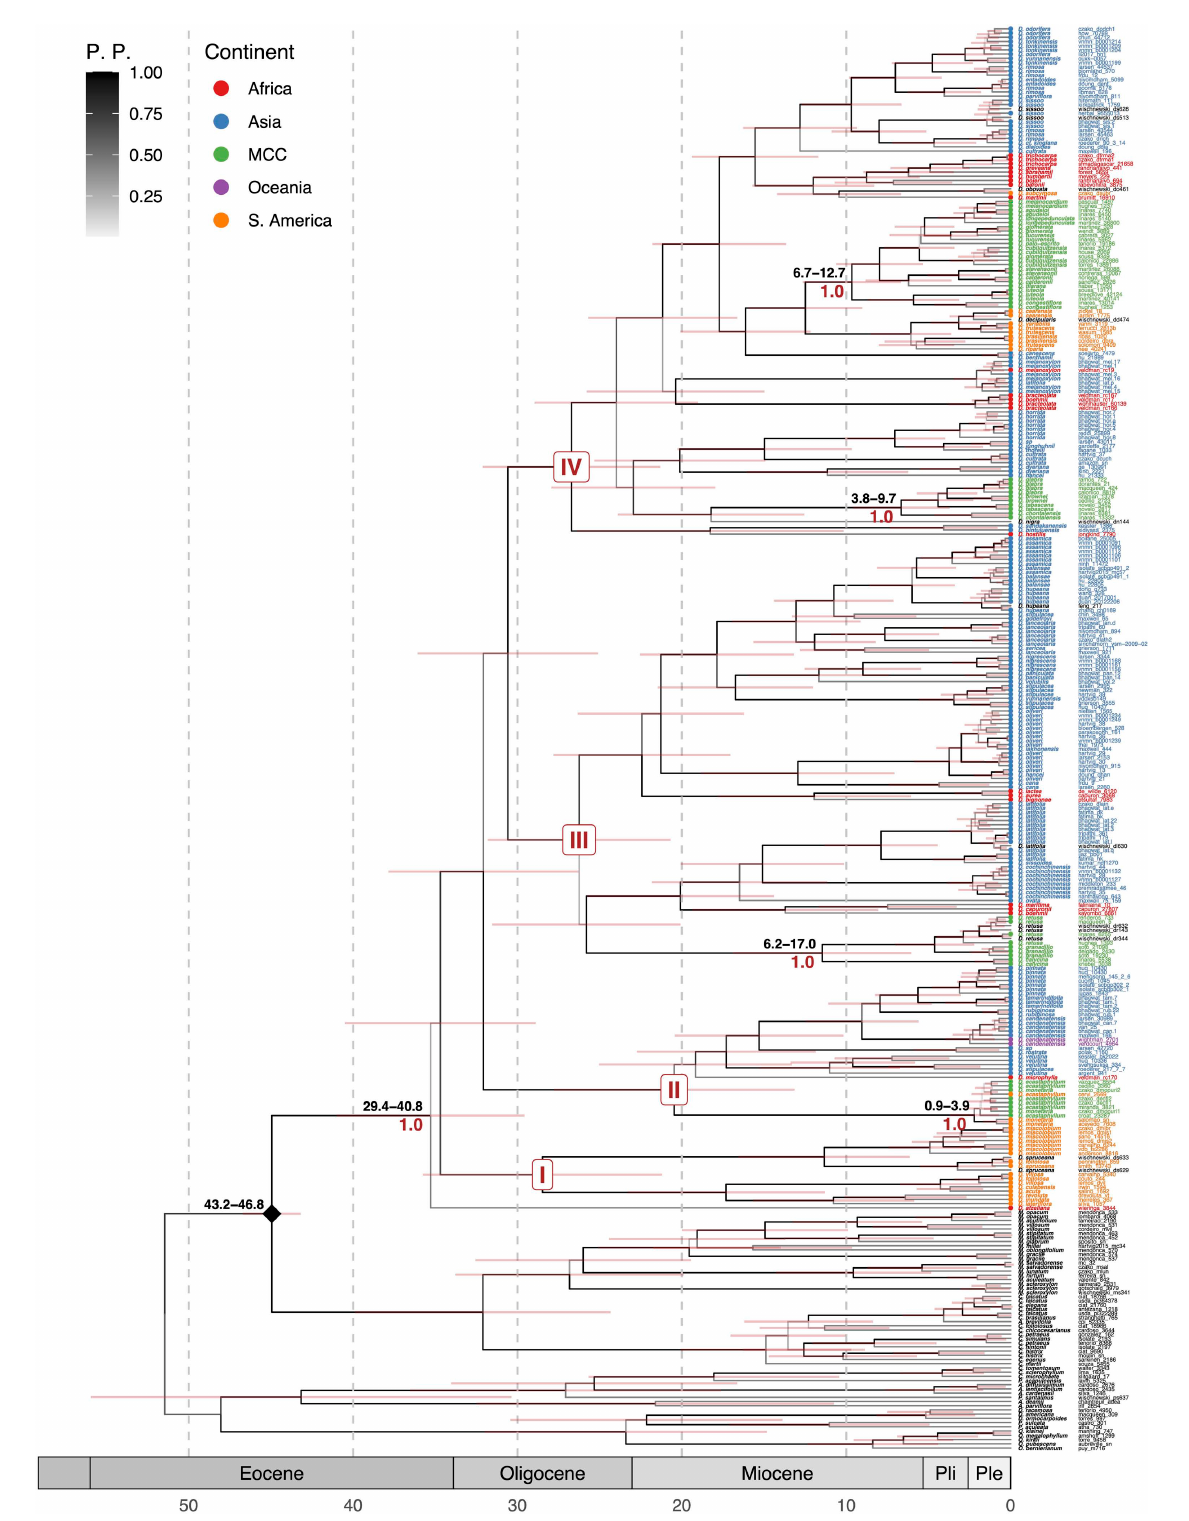
FIGURE3 ITS calibrated tree of Dalbergia . Above the branches, the estimated age range of the clades is in black font. Local posterior probabilities are shown under branches in red font. Shading bottom bars represent geological epochs. The diamond mark represents the calibration node. The bars on the branches represent the range of the 95% confidence interval in the Bayesian